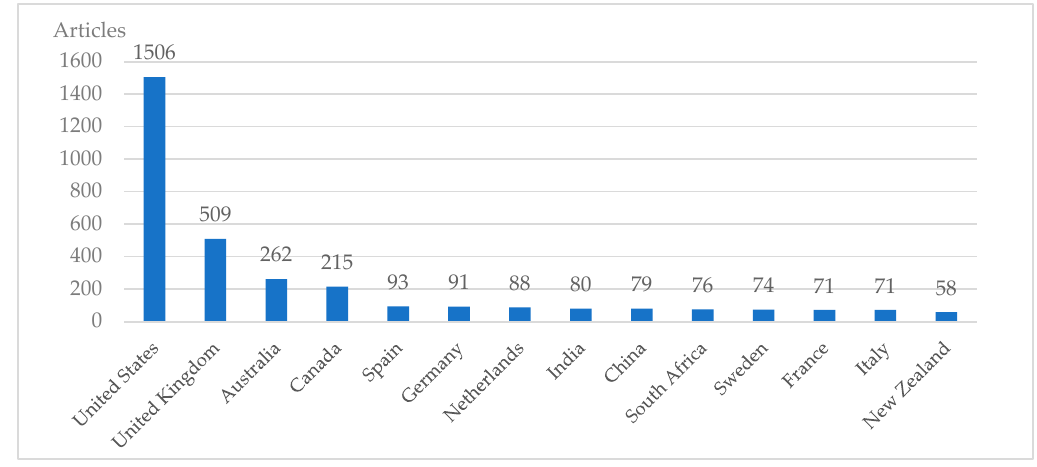
Figure 7. Documents by country.